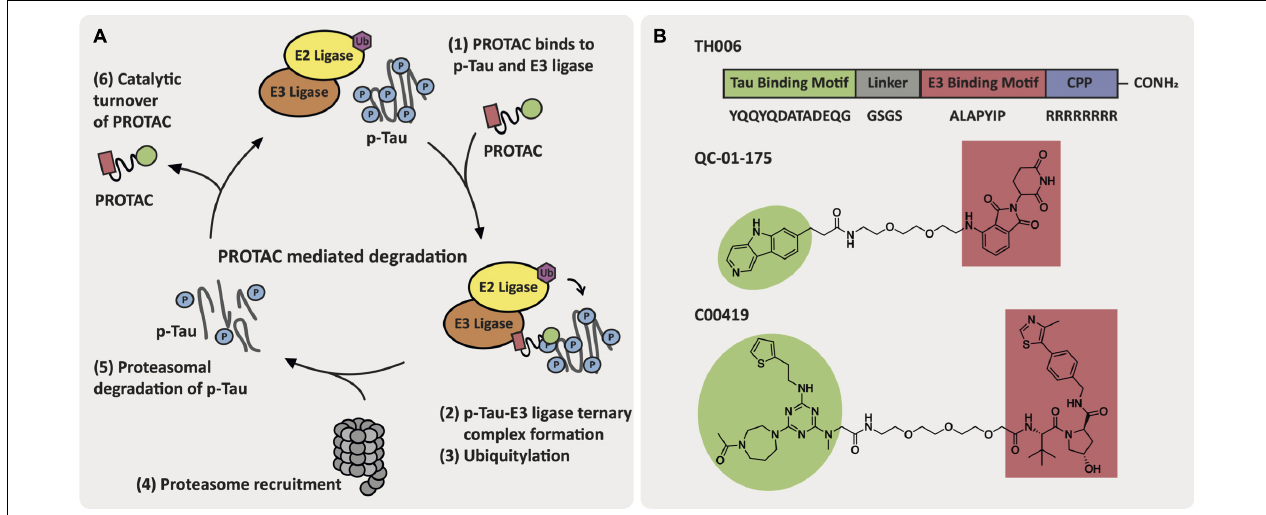
FIGURE 5 | AD-relevant tau-targeting PROTAC approaches. (A) Key events in the PROTAC-mediated degradation cycle. (B) Structures of tau-targeting PROTACs TH006, QC-01-175, and